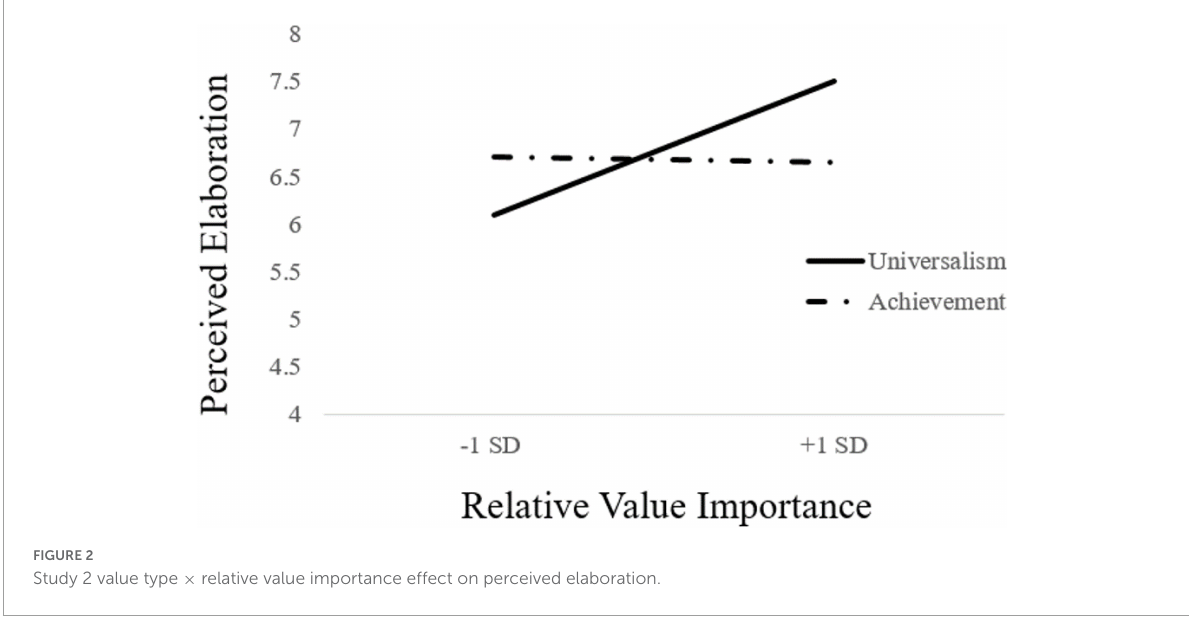
FIGURE2 Study 2 value type × relative value importance effect on perceived elaboration.